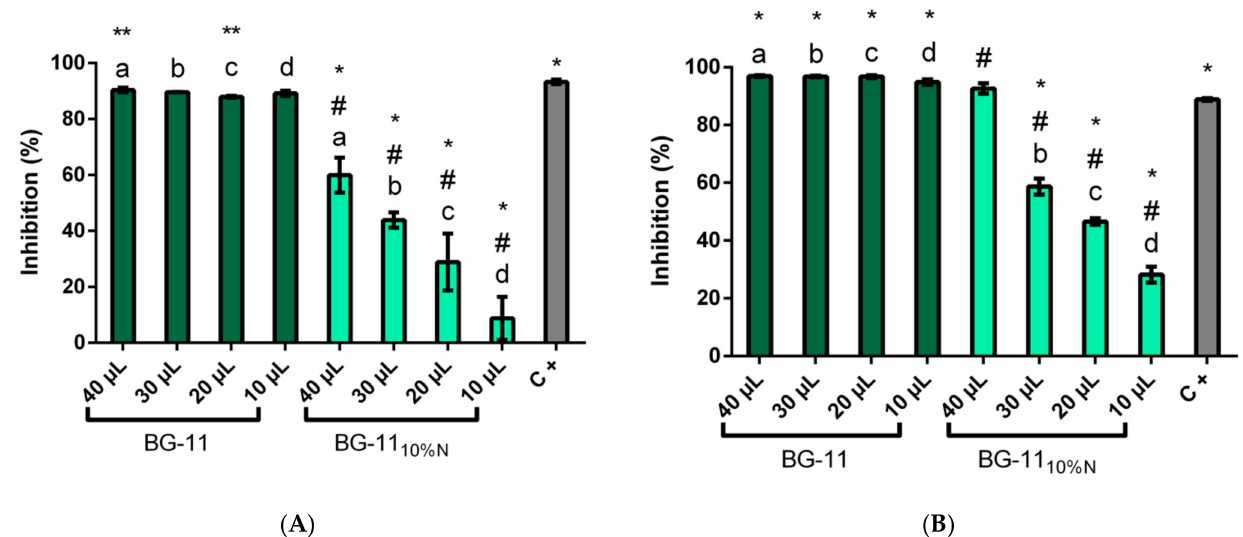
Figure 3. Inhibitory activity for ( A ) α -glucosidase and ( B ) β -glucosidase. In reaction with pNPG- α and pNPG- β , respectively, here shown in %, according to the absorbance at 410 nm in the colorimetric assay, methanolic extracts from Synechococcus sp. GFB01 growth in BG-11 and BG-11 10% N were evaluated, using conduritol β -epoxide as positive control (C+). (*) Significant difference ( p < 0.05) between samples and positive control for inhibition, commercial inhibitor; (**) significant difference between BG-11 40 and 20 µ L extract, for α -glucosidase; (#) significant difference between BG-11 10%N extracts; (a) significance between the different volumes tested, 40 µ L; (b) 30 µ L; (c) 20 µ L and (d) 10 µ L.